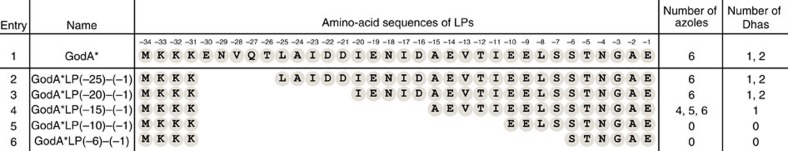
Summary of the LP truncation in the FIT–GodD/E/F/LazF system.The leader peptide regions of the truncated GodA* expressed in the FIT–GodD/E/F/LazF system are shown. Residues are shown by grey circles.